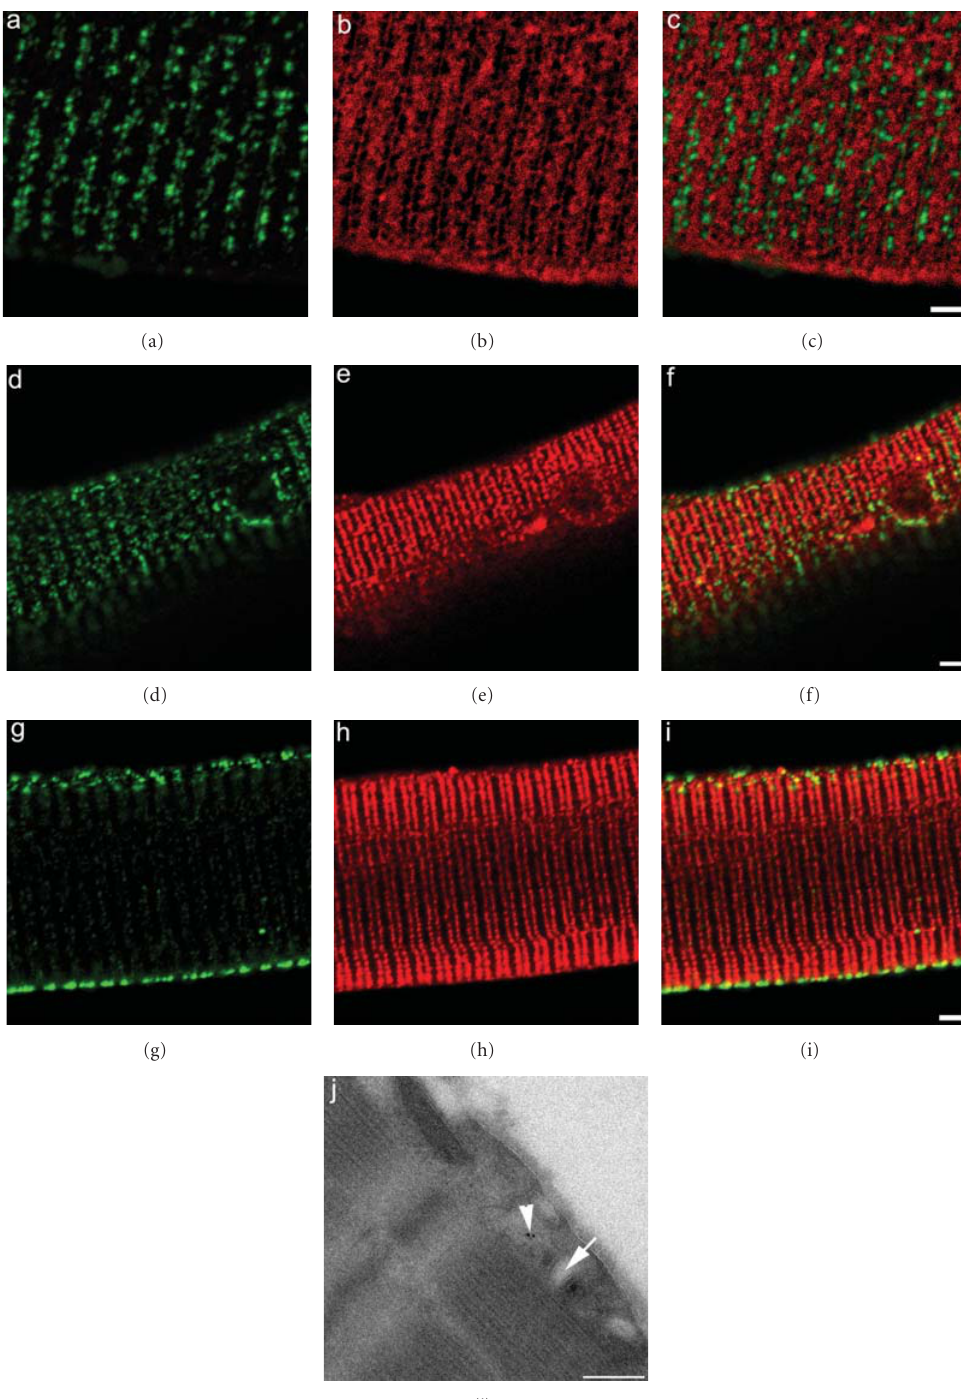
Figure 1: Flotillin 1 resides in the DGC-deficient regions in structures near transverse tubule openings. A confocal section at the sarcolemma level indicates that flotillin 1 (a) appears as spots of irregular shape. Double staining for β -dystroglycan (b) and the merged image (c) show that dystroglycan and flotillin 1 do not colocalize. A confocal section at the sarcolemma level indicated that flotillin 1 (d) and DHPR (e) that mark transverse tubules are flanking each other, demonstrated in the merged image (f). A longitudinal confocal section in the middle of a myofiber indicates that flotillin 1 (g) exhibits intense staining that seems to be an extension of the DHPR staining (h) as demonstrated in the merged image (i). Immunoelectron microscopy for flotillin 1 in EDL section shows gold particles (arrowhead) in a structure beneath the sarcolemma near the transverse tubule neck (arrow) (j). Scale bars, 2 μ m (a–i); 250nm